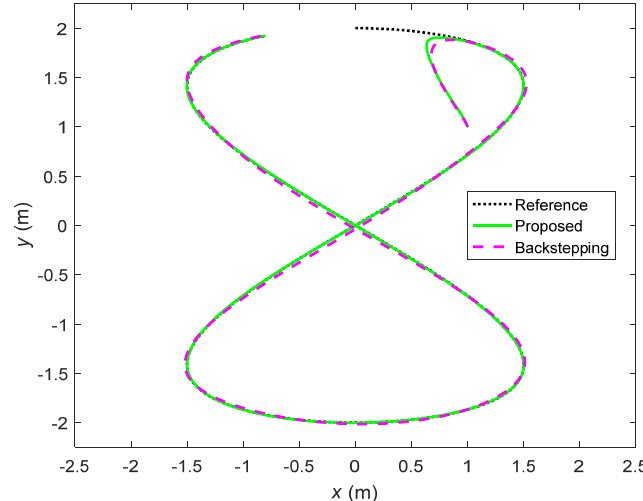
Figure 11. Planar trajectory tracking of the USV (Case 2).